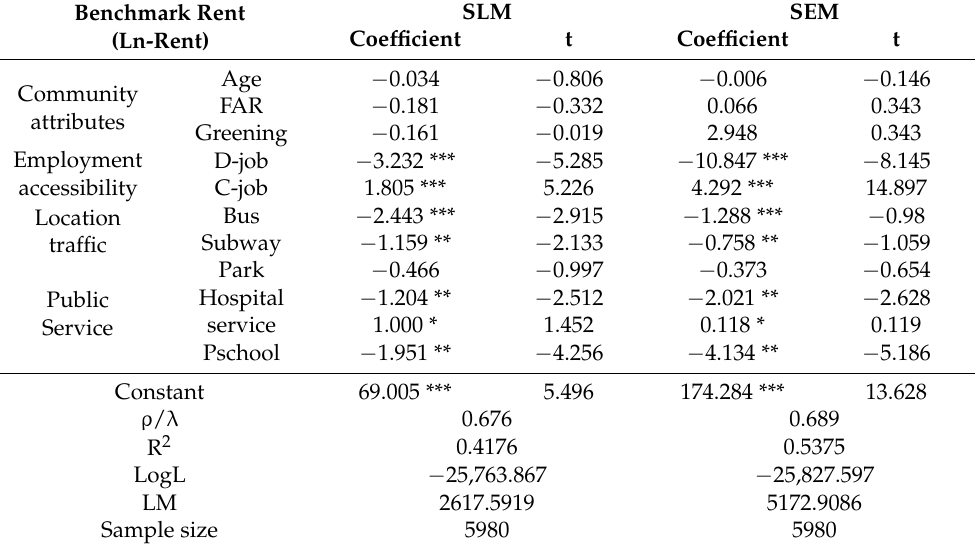
Table 5. Spatial lag model (SLM) and spatial error model (SEM) of benchmark rent. Benchmark